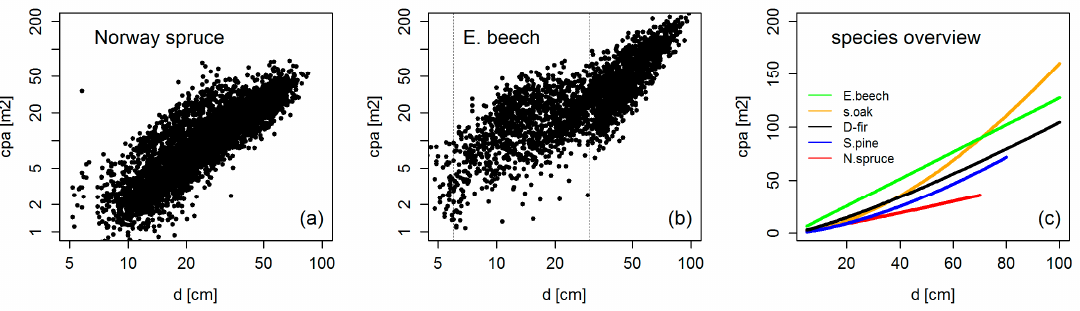
Figure 7. Observations of crown projection area, cpa, and stem diameter, d, on mono-specific long-term experimental plots in South Germany. ( a , b ) Measurements exemplarily shown for Norway spruce and European beech. ( c ) Allometric relationships cpa-d for five primary tree species fitted by regression analysis (see model 2 in Table 1).